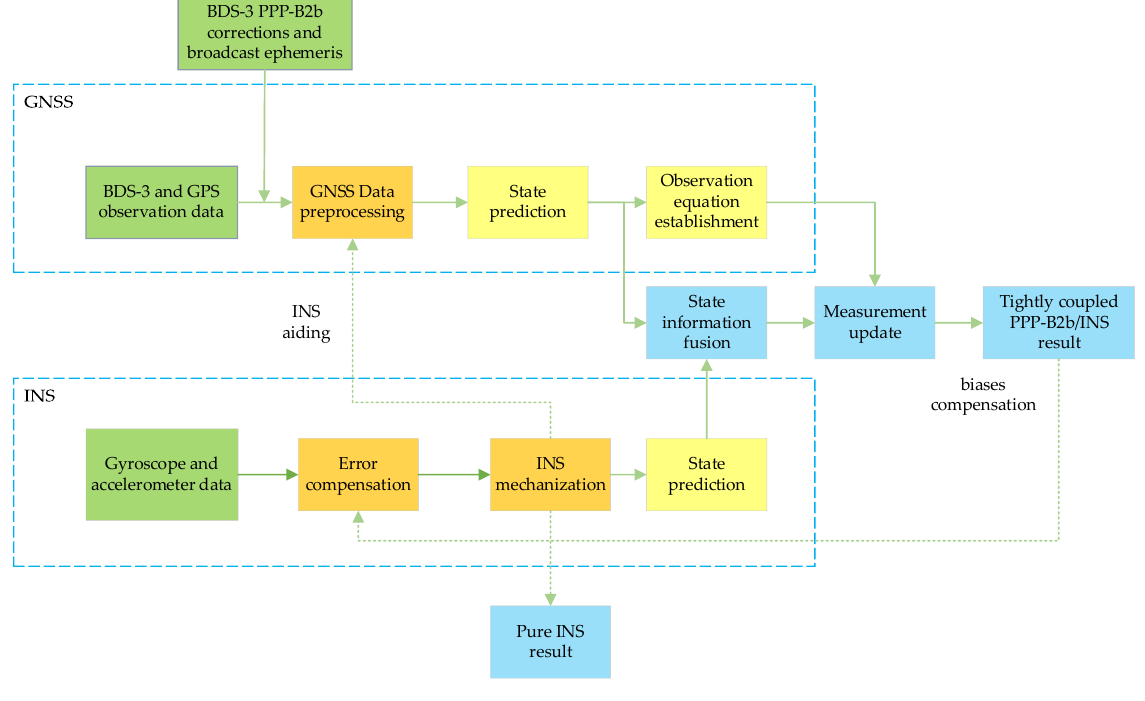
Figure 1. Flowchart of tightly integrated PPP − B2b/INS.